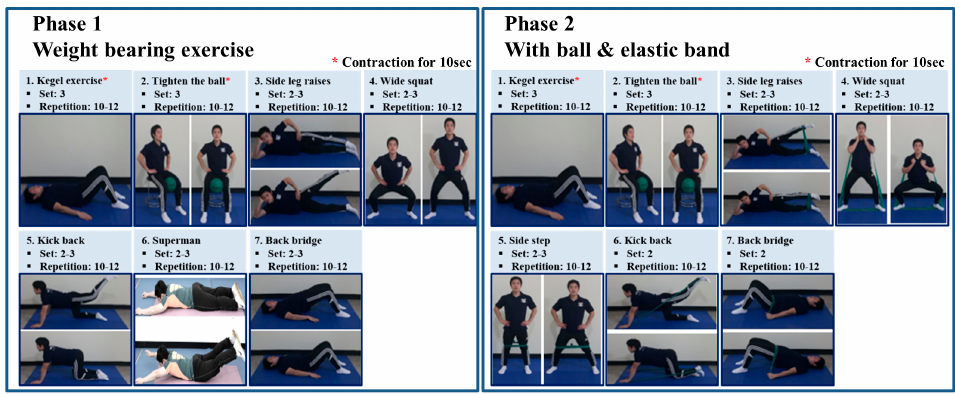
Figure 1. Exercise program protocol. * Contraction for 10 s .